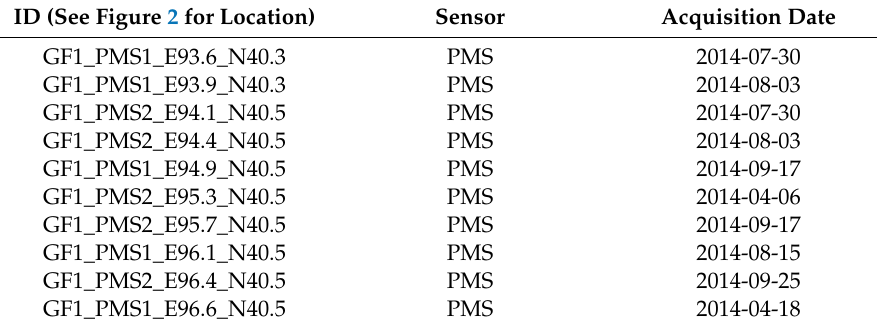
Table 1. GF-1 panchromatic and multispectral (PMS) data used in Dunhuang. ID (See Figure 2 for Location)